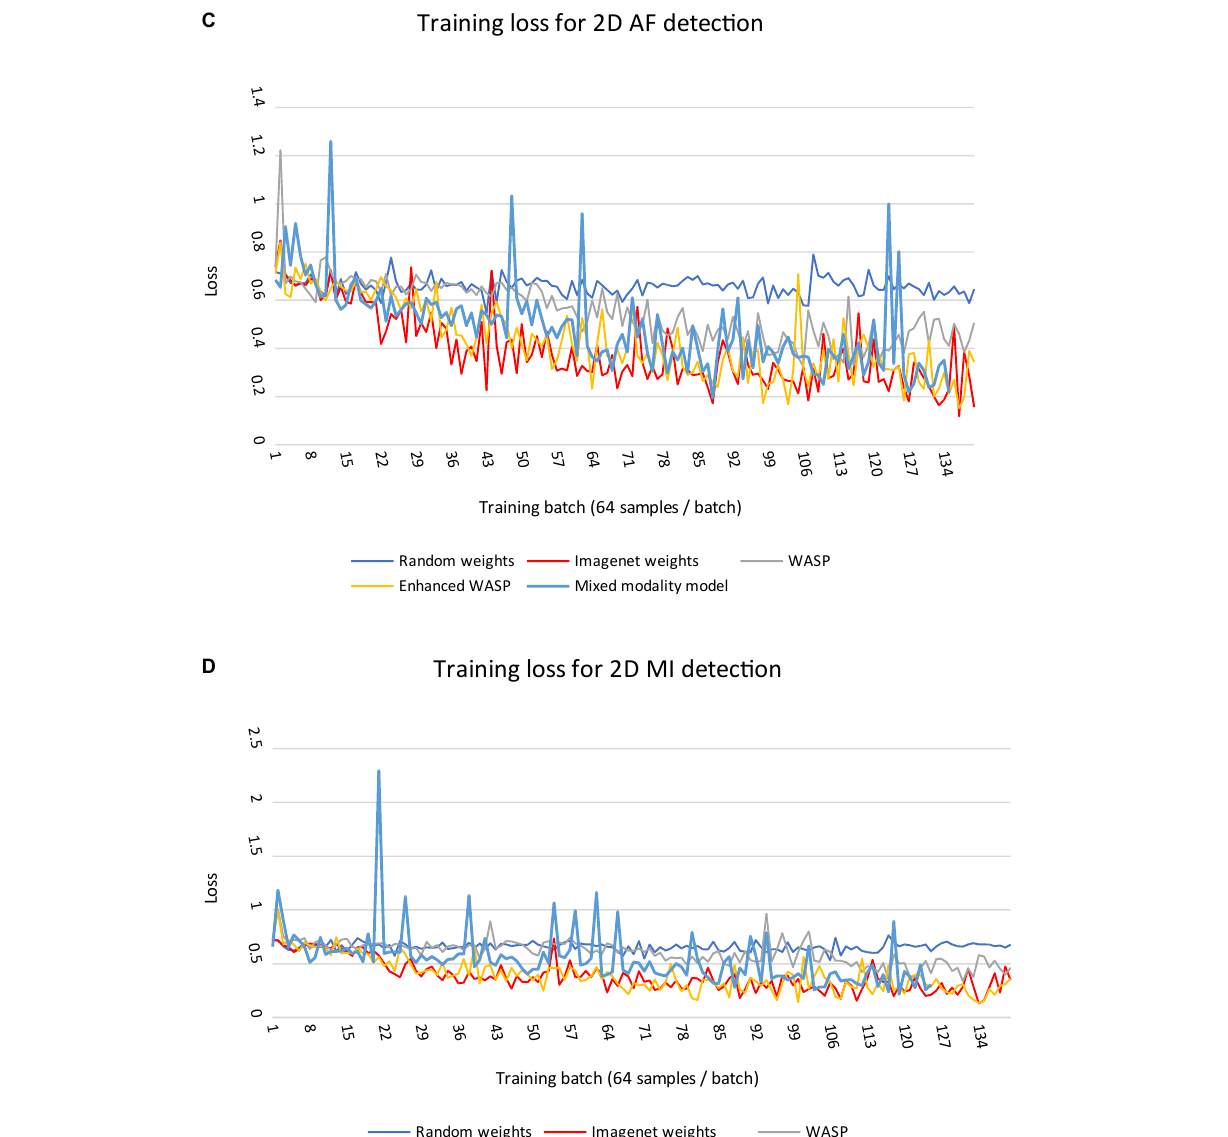
expedited convergence during fine-tuning and produced